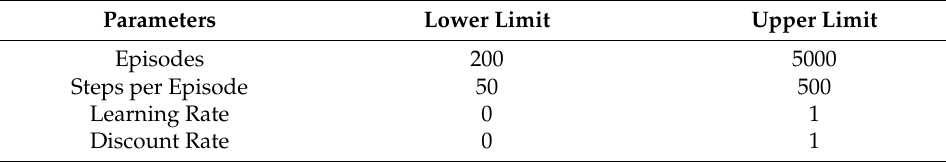
Table 5. Upper and Lower Limits of Optimization Parameters.